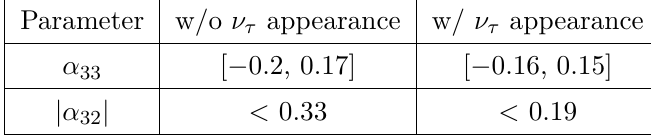
Figure 8 . Comparison between the DUNE sensitivities on | α 32 | (left panel) and α 33 (right panel) when ν appearance channel is included in the analysis (red lines) and the case where no τ events τ are analyzed (blue lines). True values of the standard oscillation parameters are taken from table 2. All results have been obtained marginalizing over δ in the range [ − 180 ◦ , 180 ◦ ] and θ in the CP 23 range [40 ◦ , 50 ◦ ] . For | α (left panel), we also marginalize over φ in the range [ − 180 ◦ , 180 ◦ ] . 32 | 32